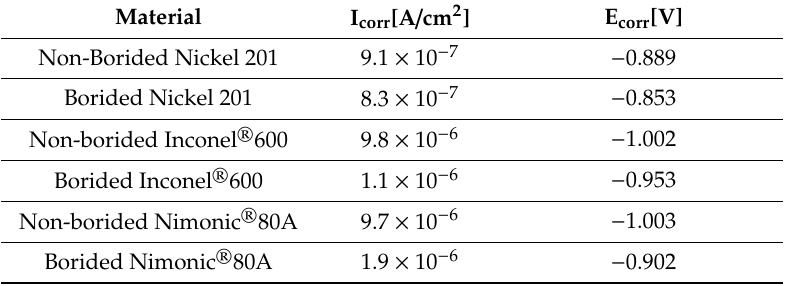
Figure 3. XRD patterns of borided layers produced on: ( a ) Nickel 201, ( b ) Inconel ® 600 alloy and ( c ) Nimonic ® 80A alloy. Table 2. Electrochemical parameters I corr and E corr , determined based on the polarization